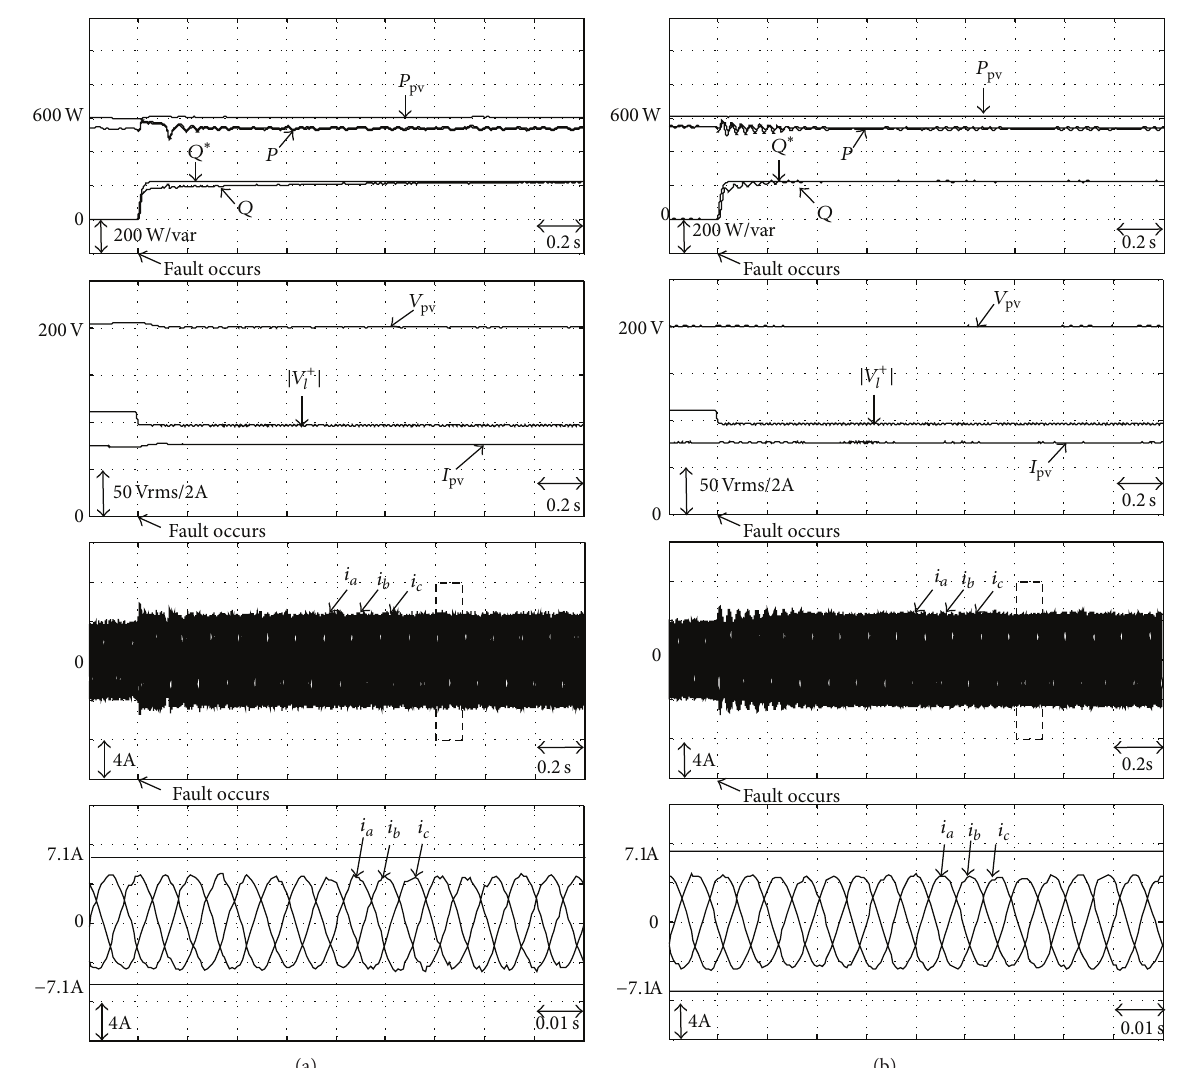
Figure 6: Experimental results of Case 1: (a) using PI controllers and (b) using 2D-RFCMANN controllers.